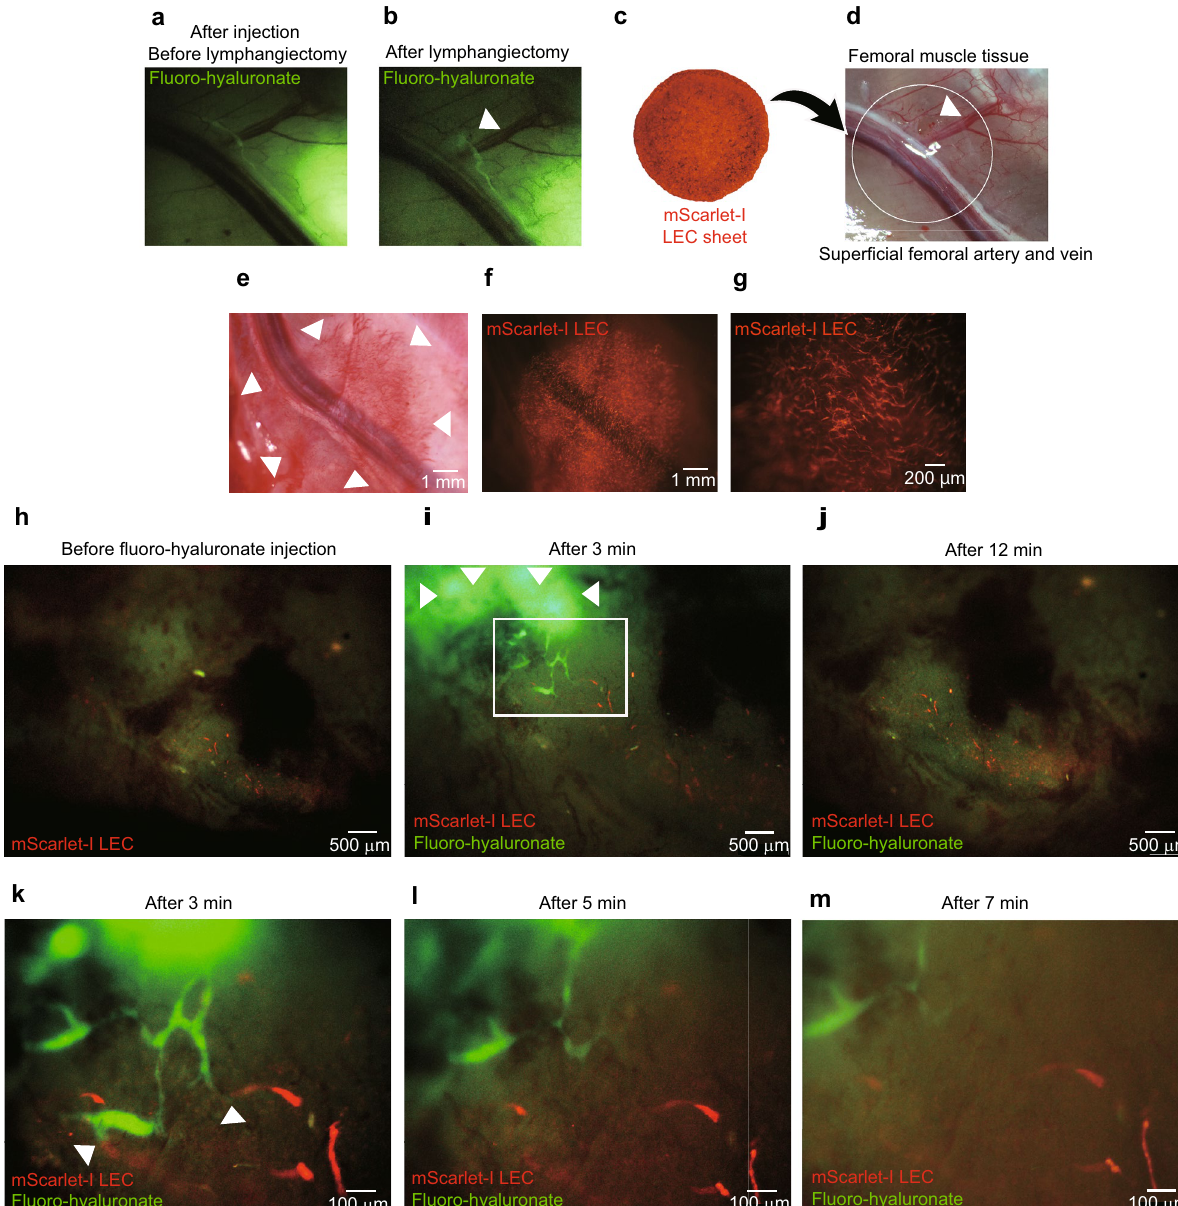
Figure 5. Transplanted cell sheets containing a localized network of mScarlet-I-labeled LECs contribute to the reconstruction of functional lymphatic vessels in a rat model of femoral lymphangiectomy. ( a ) Confirmation of lymphatic vessel appear alongside to superficial femoral artery and vein in femoral muscle by injecting fluorescent hyaluronic acid (fluoro-hyaluronate) in distal femoral muscle. ( b ) Leakage of fluoro-hyaluronate was observed after lymphangiectomy by resecting femoral muscle tissue. ( c ) A cell sheet containing a localized network of mScarlet- I-labeled LECs. ( d ) A rat model of femoral lymphangiectomy was generated by resecting a 1.5 × 1.5 mm piece of femoral muscle tissue including its lymphatic vessels. Cell sheets containing a localized network of mScarlet-I-labeled LECs were transplanted onto the defect. The white circle indicates the region where the cell sheets were transplanted. ( e ) Macroscopic image of the femur 1 week after transplantation of the cell sheet construct. Neovascularization was evident in the region of the muscle surface where the cell sheets had been transplanted (arrowheads). ( f ) Macroscopic fluorescence observation of mScarlet-I-labeled LECs. ( g ) Magnified image showing mScarlet-I fluorescence. A reticular network was evident that was similar to that seen before transplantation. ( h–m ) The ability of the lymphatic vessels to take up substances from the interstitium was evaluated by injecting fluoro-hyaluronate. Only the red signal of the mScarlet-I-labeled lymphatic endothelium was observed before the injection of fluoro-hyaluronate ( h ). A green signal in the lymphatic vessels was observed 3 min after the injection of fluoro-hyaluronate (arrowheads indicate the interstitial area), demonstrating that the host lymphatic vessels had taken up hyaluronic acid from the interstitium ( i ). The green signal in the lymphatic vessels disappeared after 12 min, implying that the lymphatic vessels had circulated the fluoro-hyaluronate away from the region of observation ( j ). The magnified image ( k–m ) of the region marked by the white rectangle in ( i ) shows connections between the host lymphatic vessels and the transplanted lymphatic vessels at 3 min after fluoro-hyaluronate injection ( k , arrowheads). The green signal gradually disappeared over the subsequent 4 min ( l , m ), which would be consistent with the flow of lymph fluid away from the region of